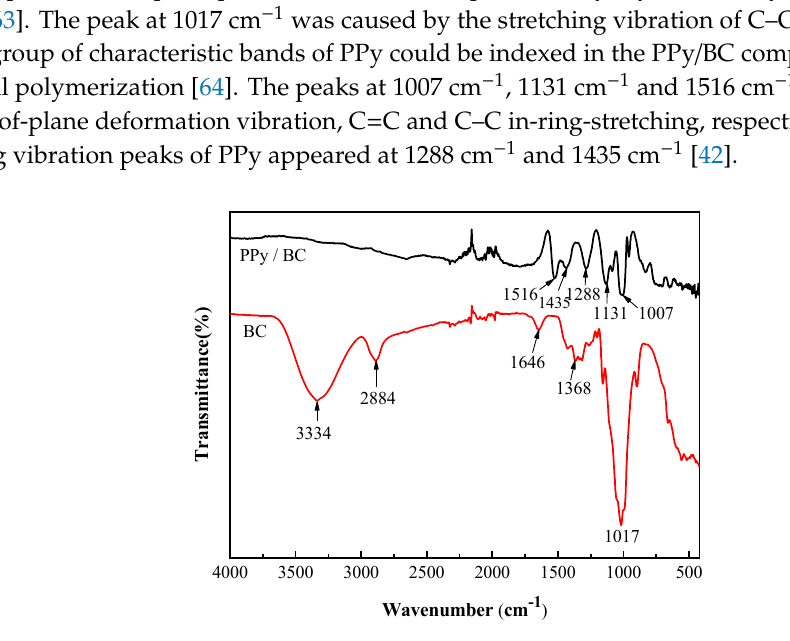
Figure 5. Fourier transform infrared (FT-IR) spectra of pure BC and PPy/BC membranes.